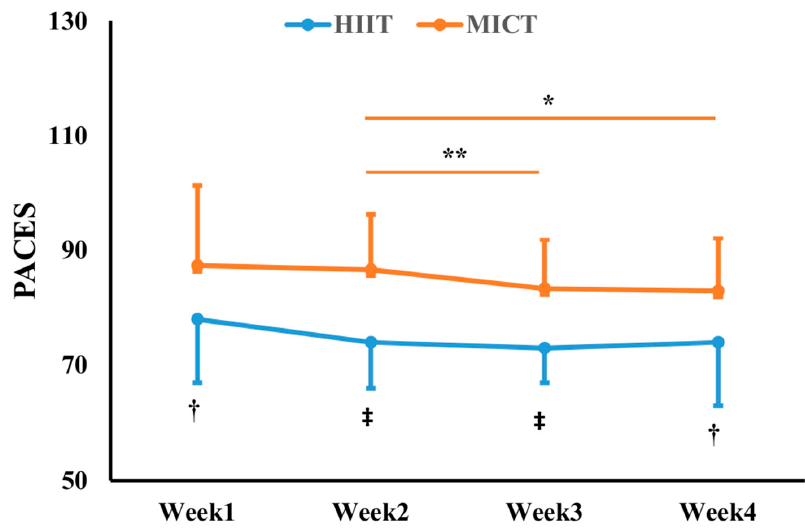
Figure 1. Scores of physical activity enjoyment scale (PACES) during 4-week exercise